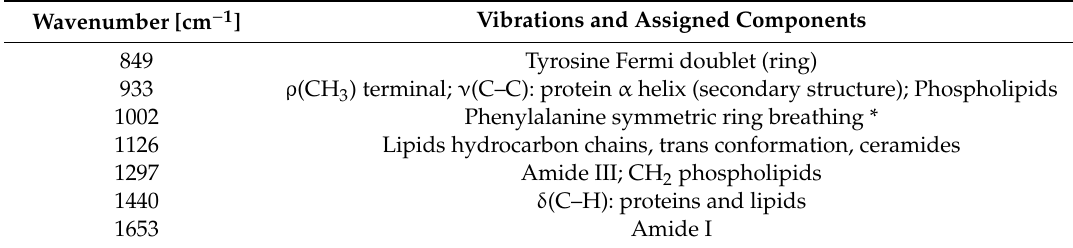
Figure 3. Stratum corneum thicknesses of fresh and frozen EpiSkin ™ RHE estimated from the locations in the cryo-sections at which Raman spectra were acquired. Table 2. Assignments to selected Raman peaks in the stratum corneum of EpiSkin ™ reconstructed human epidermis, based on [22] ( ρ : rocking, ν : stretching, δ :